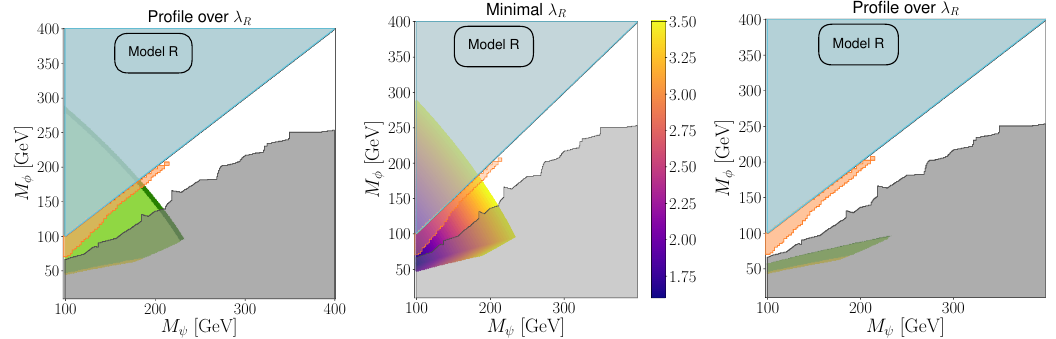
Figure 8. Several profiles of Model R. Colours for the first and third panels are the same as figure 5. The middle panel shows the lowest value of λ within 1 σ . The panels are constructed in the same way as those in figure 6. The same LHC limits as figure 7 (which do not depend on the coupling) are